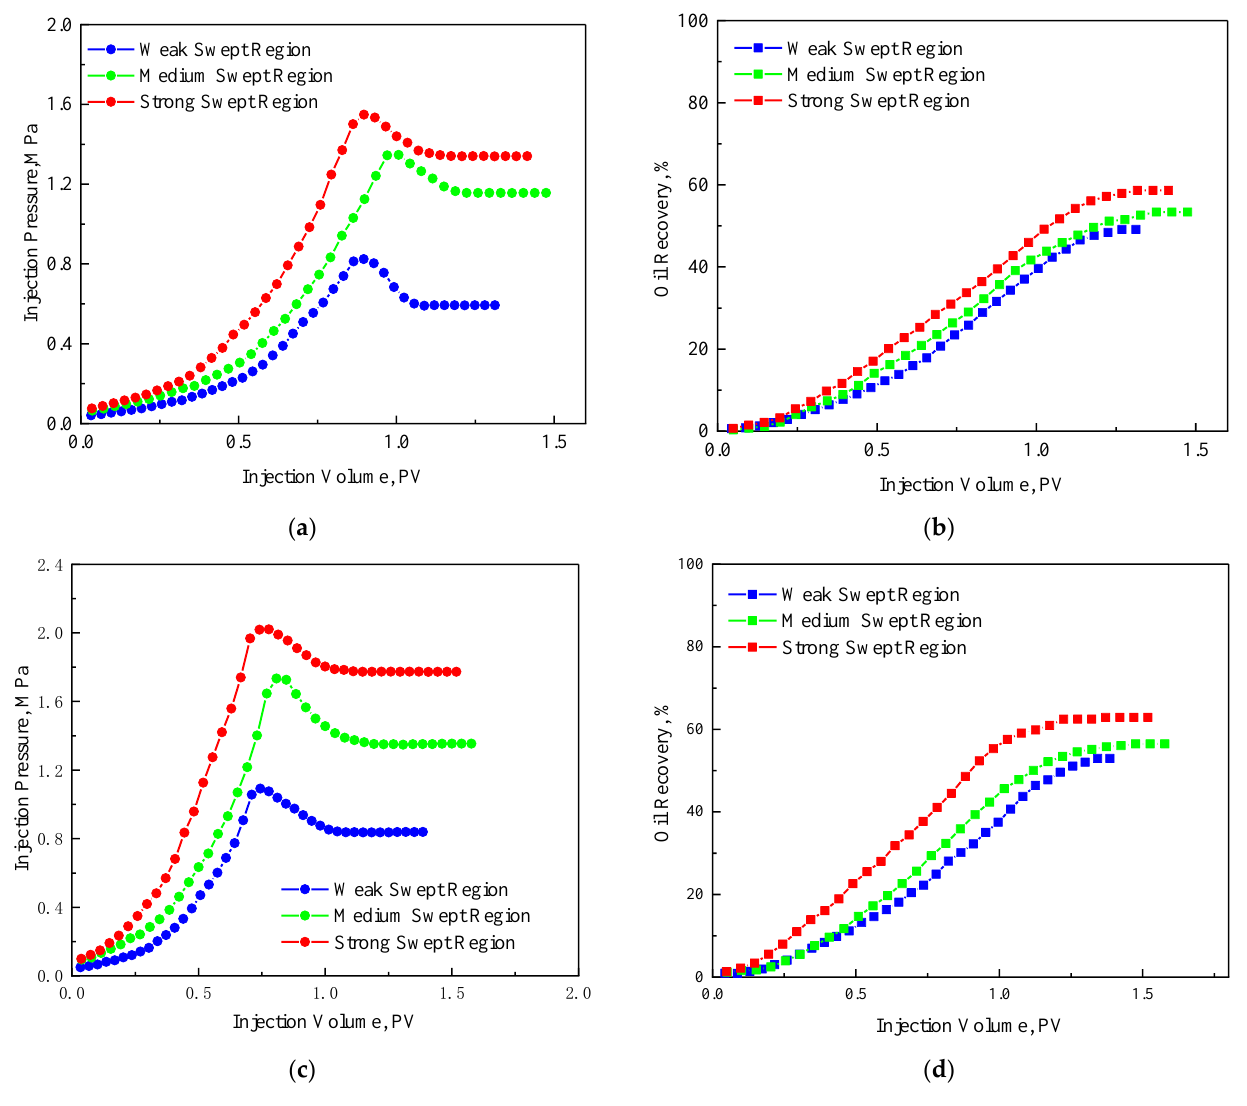
Figure 7. The injection pressure and oil recovery curves of the experiment at the core permeability is 50 mD. ( a ) Injection pressure curve with S/P viscosity is 23.5 mPa·s; ( b ) oil recovery curve with S/P viscosity is 23.5 mPa·s; ( c ) injection pressure curve with S/P viscosity is 44.6 mPa·s; ( d ) oil recovery curve with S/P viscosity is 44.6 mPa·s.